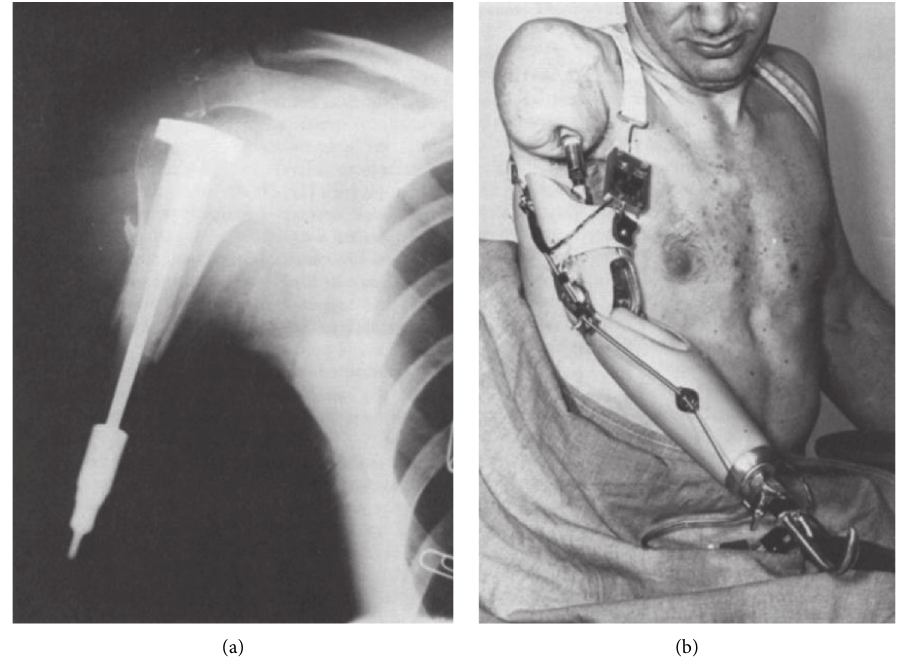
Figure 8: Cerosium implant used by Dr. Vert Mooney in 1967. (a) Radiograph and (b) clinical photo of a patient with a right humerus implant (figures adapted with permission from Mooney V., Predecki P. K., Renning J., Gray J. Skeletal extension of limb prosthetic attachments–Problems in tissue reaction. Journal of Biomedical Materials Research . 1971 Nov; 5(6):143–159).